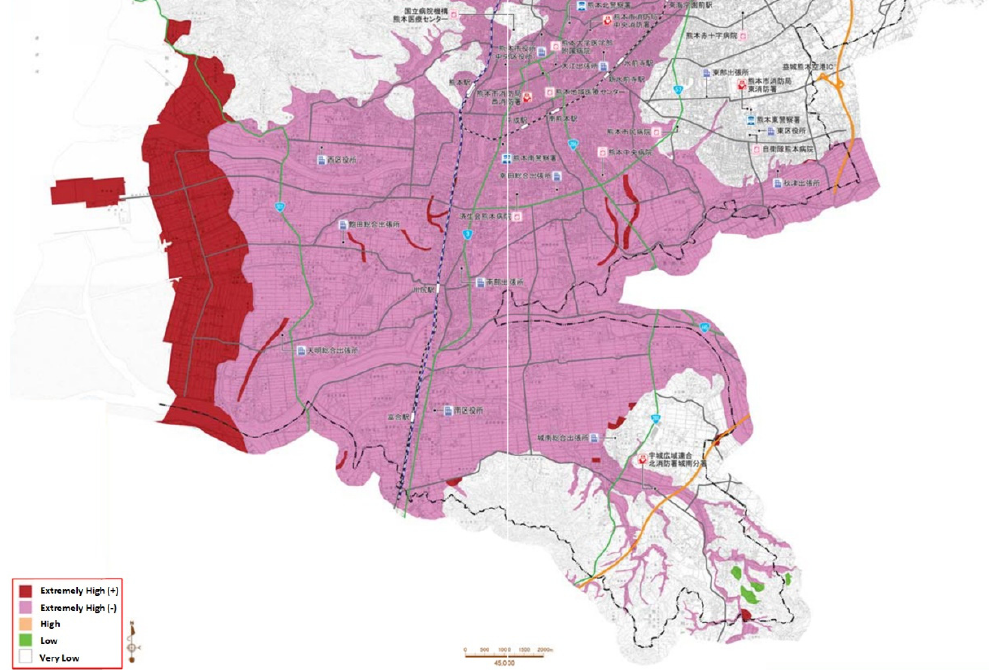
Figure 5. Liquefaction hazard map for the Kumamoto Plain at the time of the 2016 KES (after [37]).